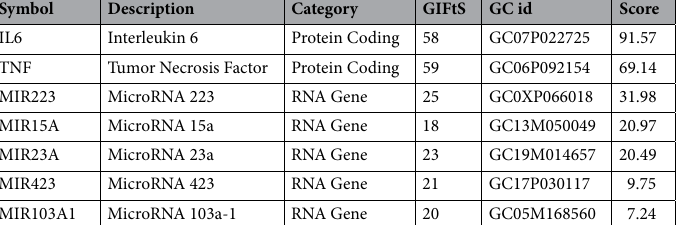
Table 7. GeneCards’ search. GIFsT, GeneCards Inferred Functionality Scores; GC id, GeneCards Identifiers; Score, Relevance